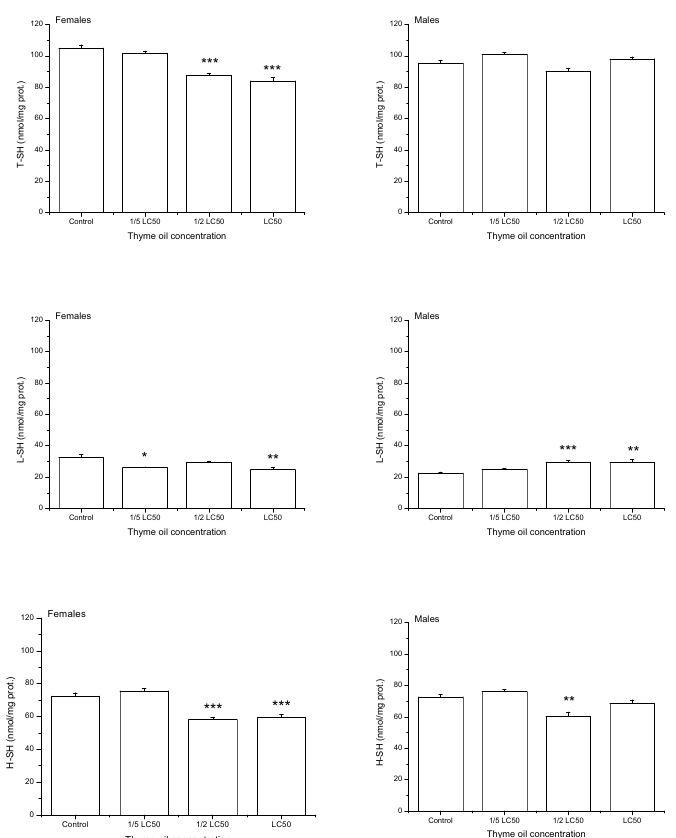
Figure 5. Total thiols (T-SH), low-molecular mass thiols (L-SH) and high-molecular mass thiols (H-SH) contents (means and standard errors for 5 replicates) in female and male Acanthoscelides obtectus adults one day after exposure to bean seeds treated with thyme oil. Significant differences in treatment groups from the control are marked by asterisks (* p < 0.5, ** p < 0.01, *** p < 0.001).